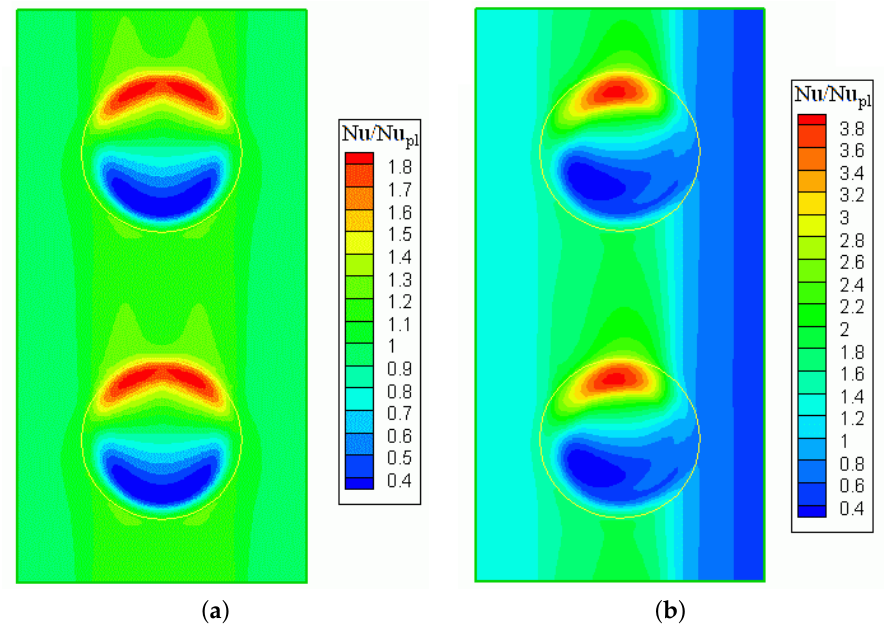
Figure 9. Comparison of fields of relative Nusselt numbers for reliefs with spherical dimples 0.1 ( a ) and 0.2 ( b )